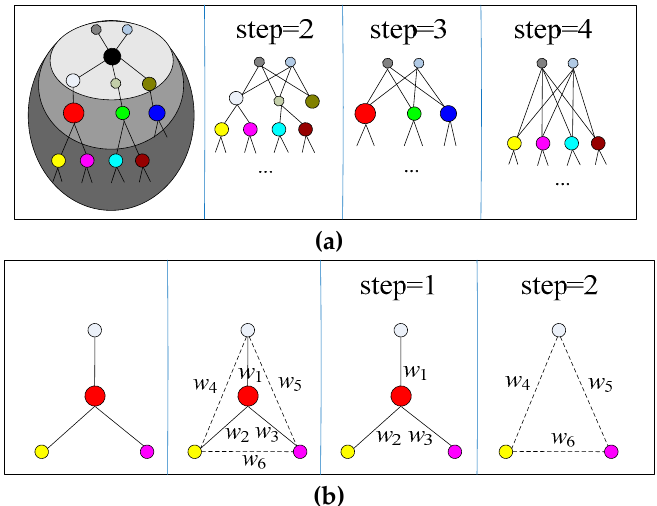
Figure 1. Algorithm framework of multi-view network representation (MVNR). ( a ) Higher order neighboring relations acquisition; ( b ) Edge weight calculation.